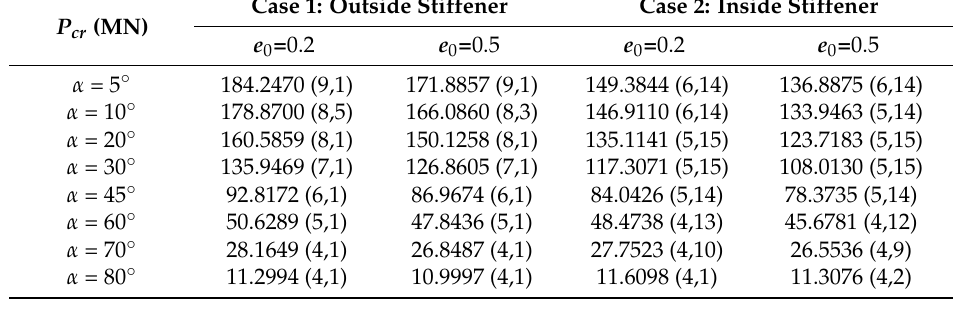
Figure 5. Effects of e 0 on critical load P cr ( k 2 = k 3 = k = 1). Table 6. Critical compression load P cr for various semi-vertex angles α .